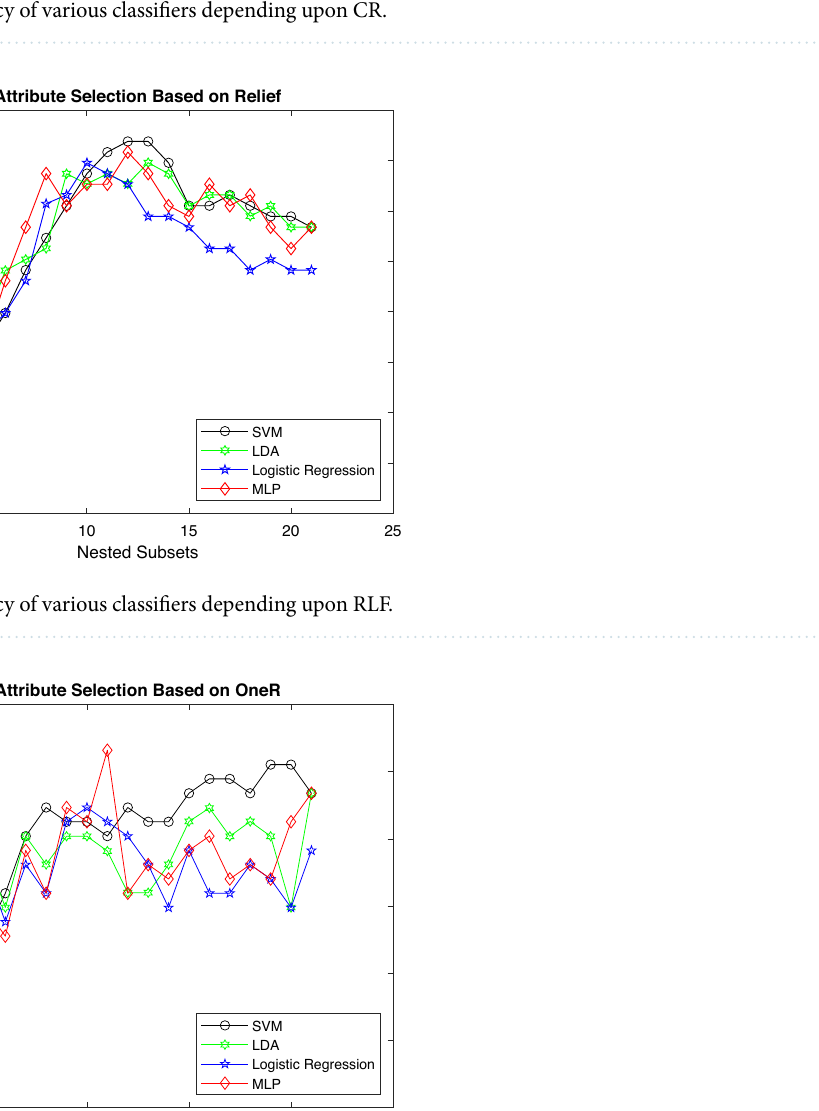
Figure 5. Accuracy of various classifiers depending upon CR.